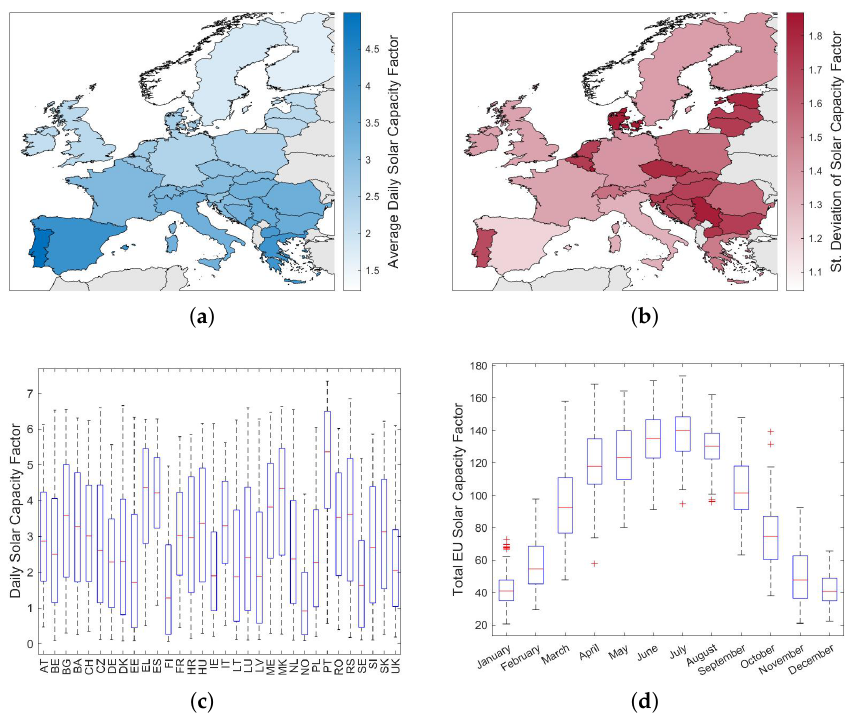
Figure 4. Statistical aspects of sample solar capacity factors: shown are the country average ( a ), standard deviation ( b ), unconditional distribution ( c ) and a seasonal analysis of the aggregate solar capacity factor ( d